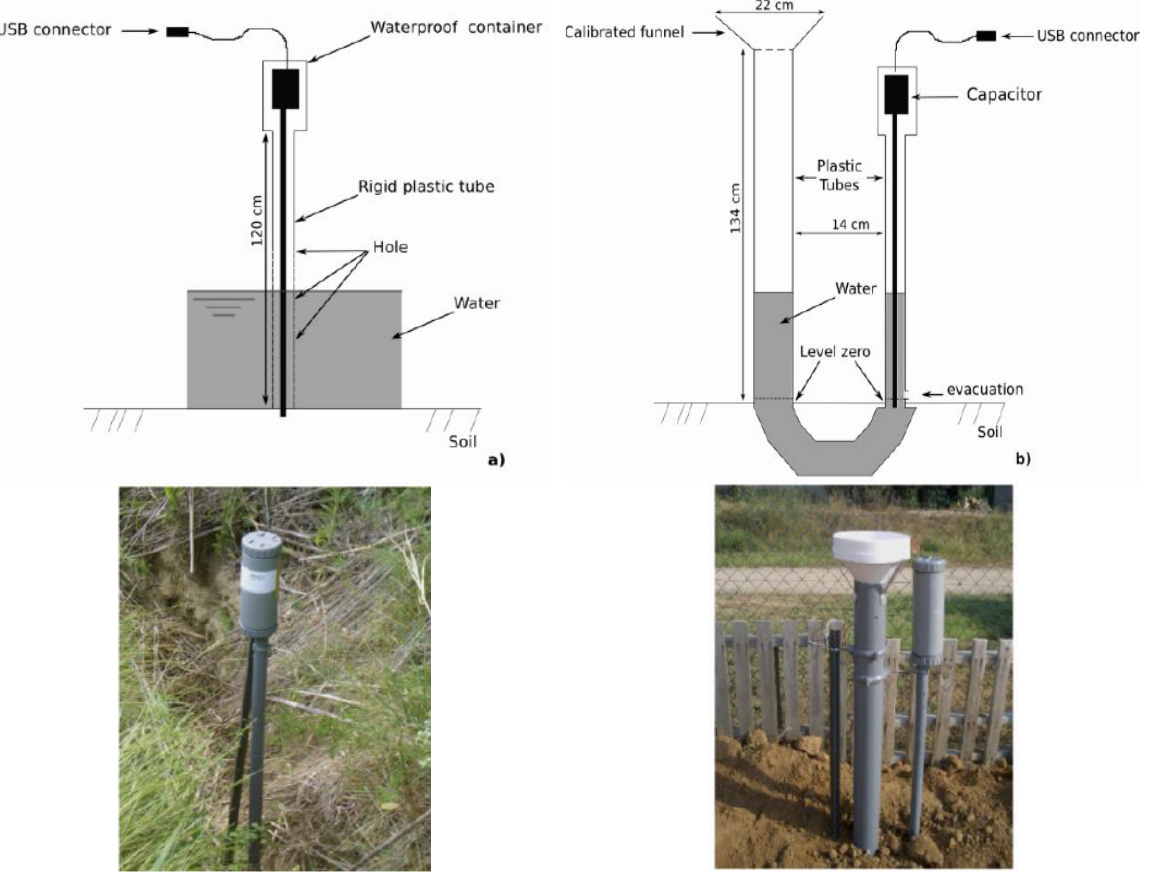
Figure 3. Monitoring setting scheme: ( a ) stage recorder, ( b ) rain